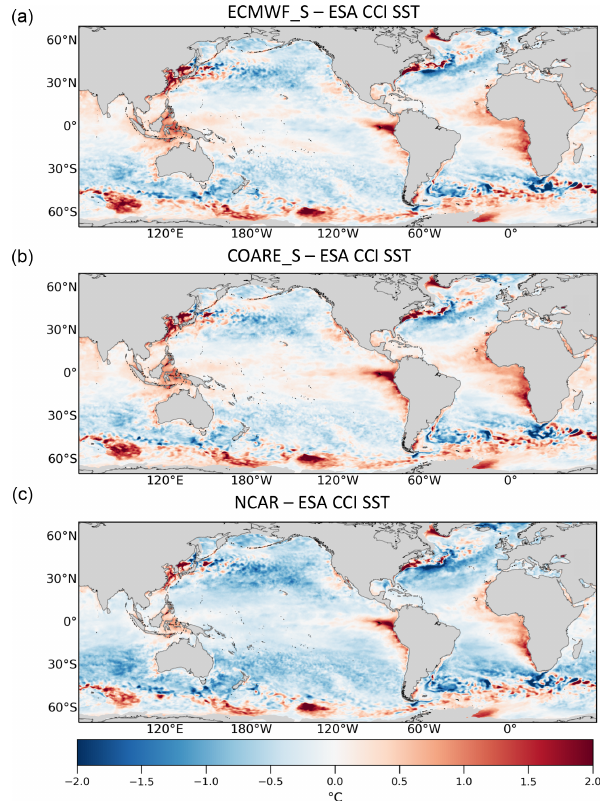
Figure 2. Annual mean SST differences for (a) ECMWF_S , (b) COARE_S , and (c) NCAR versus the ESA CCI